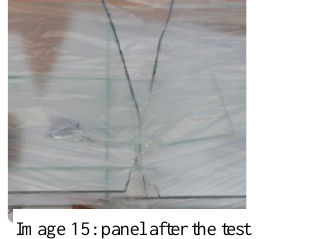
Image 13: fracture